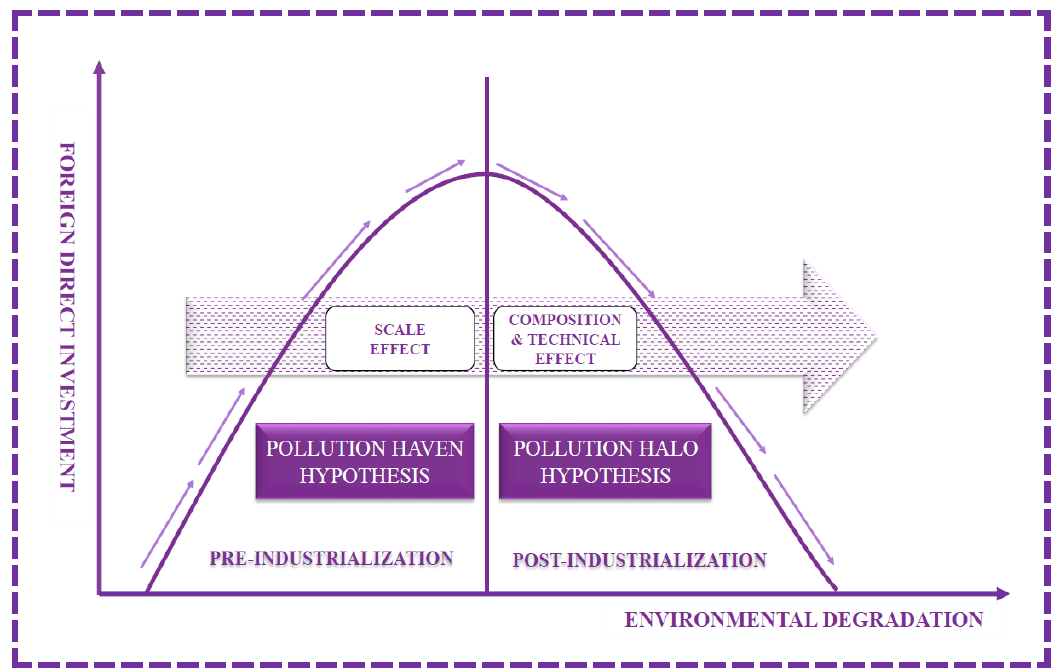
Figure 1. Inverted U-shaped association between FDI and environmental contamination